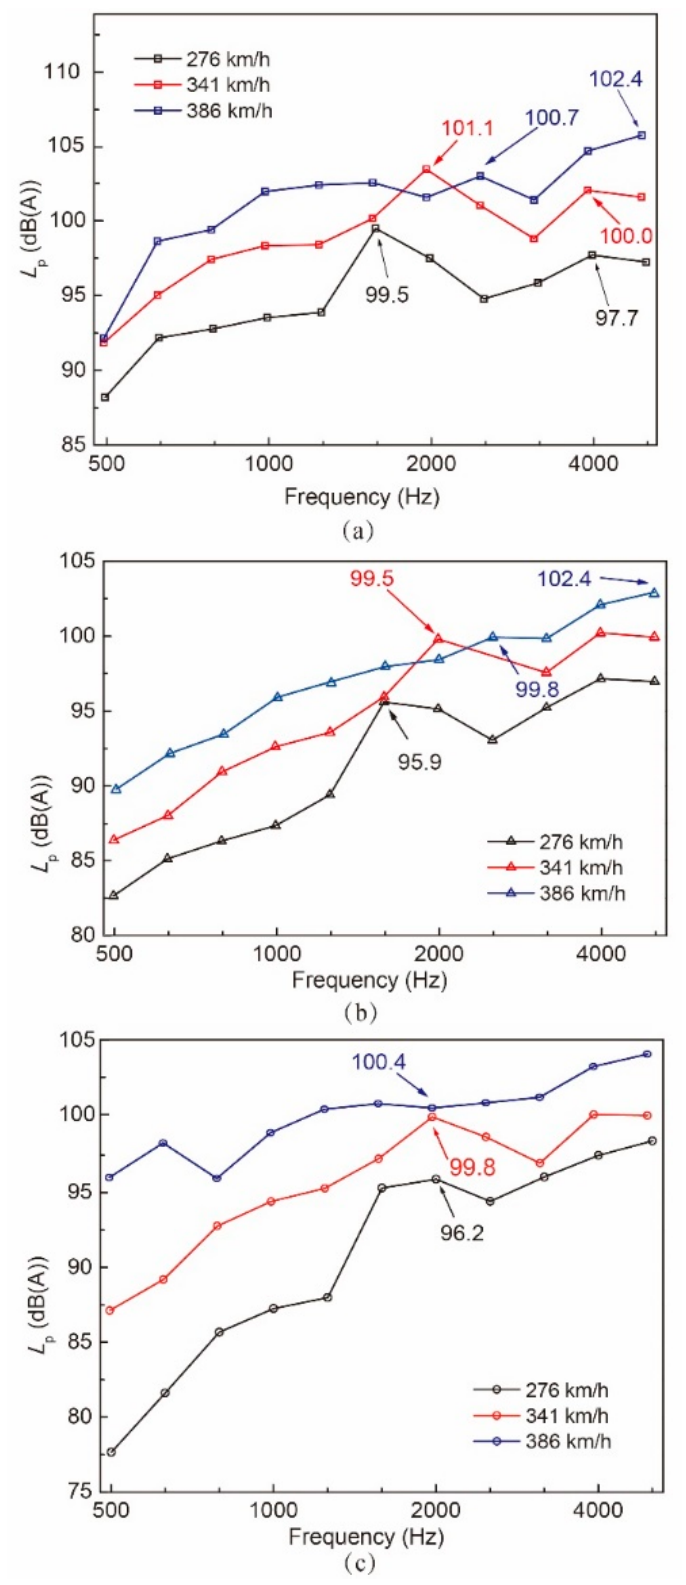
Figure 9. The main noise frequencies characteristics of high-speed trains: ( a ) wheel-rail area; ( b ) inter-coach spacing; ( c ) pantograph [47].